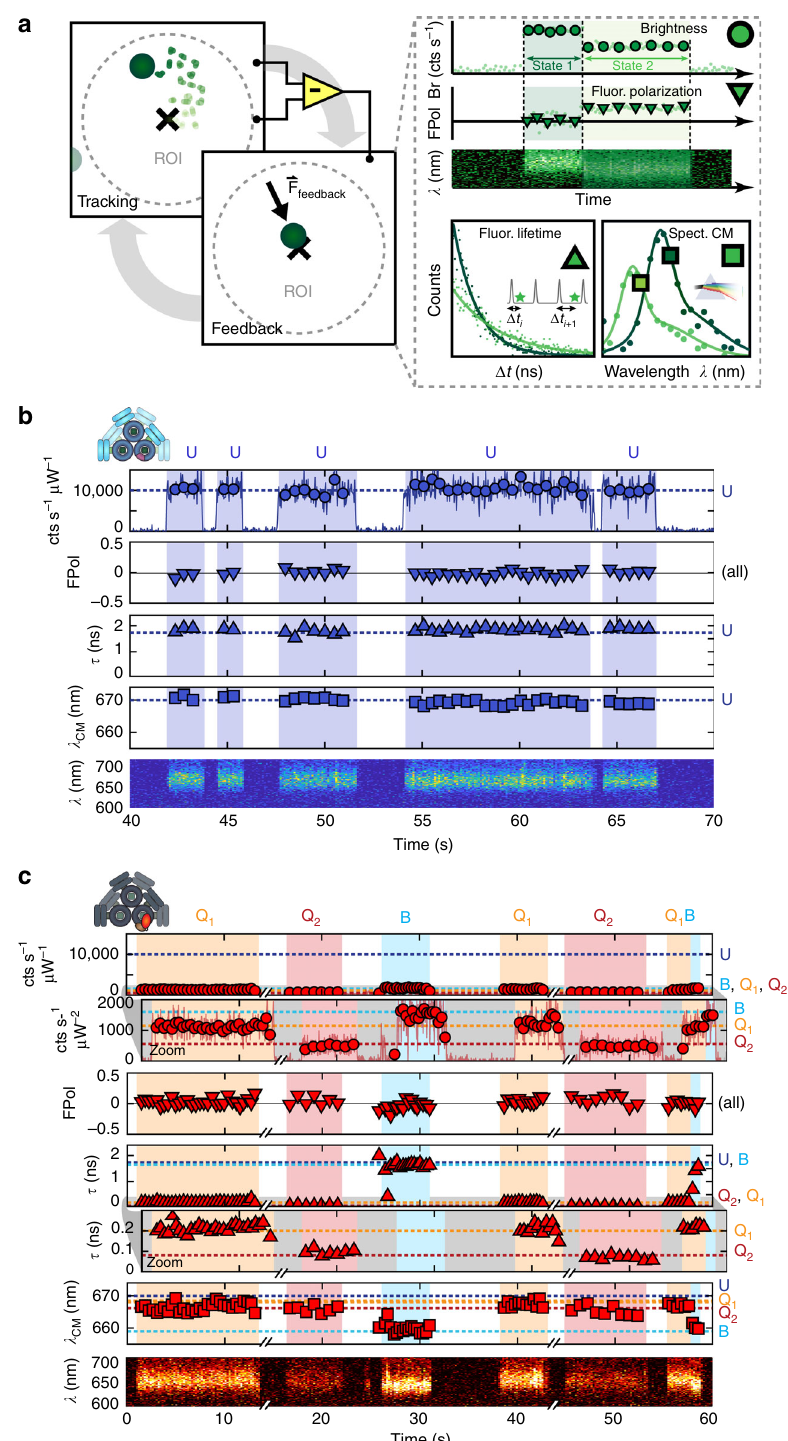
Fig. 2 Anti-Brownian trapping of single unquenched and quenched phycobilisomes. a ABEL trap schematic operation and multiparametric data collection. The position of a single particle diffusing within an observation region of interest (ROI) is monitored, while feedback is applied in an active control loop to maintain the particle within the ROI (left). Multiple photophysical parameters are monitored for each trapped particle in real time, including brightness (Br), fl uorescence polarization (FPol), fl uorescence lifetime ( τ ), and emission spectrum (Em( λ ), which can be reduced to its center of mass, λ data for all parameters (Br, FPol, τ , λ CM , and Em( λ )) for the CB-PB complex in the absence of OCP (incident excitation intensity 4.8 W cm − 2 ) shows a consistent photophysical state, U. Data are plotted in either 800-photon groups (markers) or 30-ms bins. c Raw trapping data for all parameters for CB-PB quenched by OCP (1:40). At least three distinct photophysical states (B, Q 1 , and Q 2 ) are evident in the sample containing the quenched complex. Data are plotted in either 500-photon groups (markers) or 30-ms